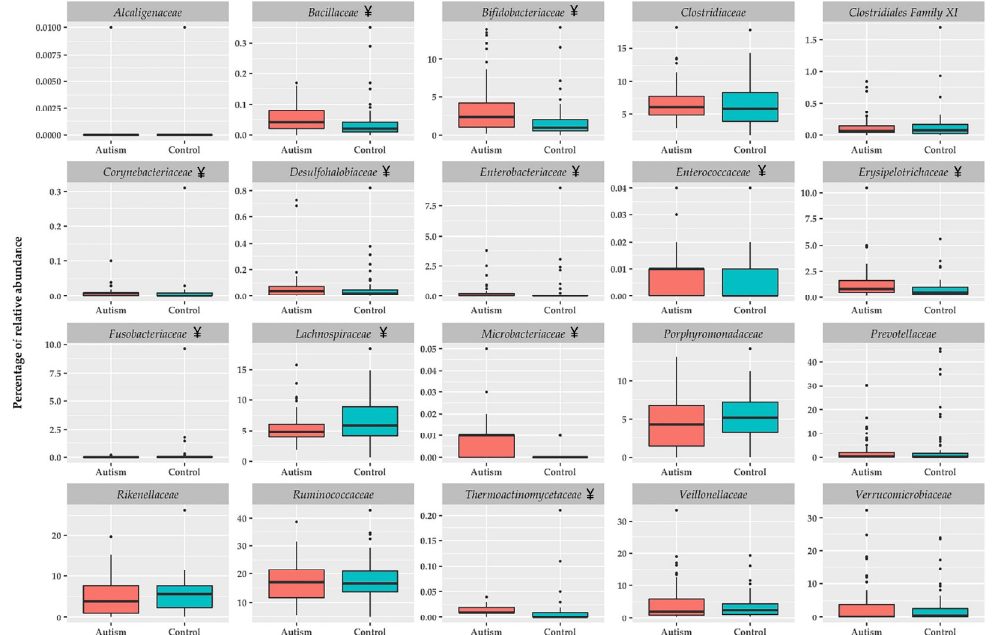
Figure 1. Relative abundance of family bacterial taxon in feces of children with ASD and healthy children. Boxplots were generated using the R software utilizing the ggplot2 package, and represent the most important bacterial families ¥ P < 0.05 vs. control group.